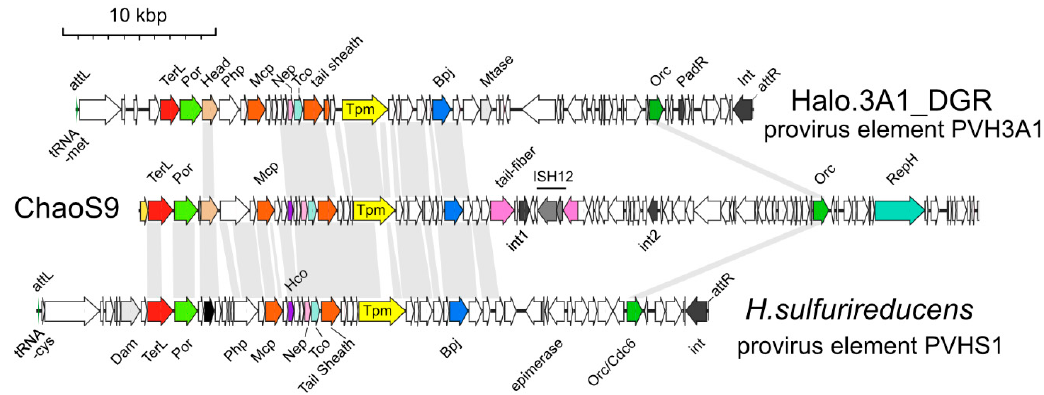
Figure 6. Provirus elements PVH3A1 and PVHS1 compared to ChaoS9. PVH3A1 from haloarchaeon strain 3A1_DGR (accession NZ_KK033114; nt 1475908-1520418), and PVHS1 from Haa. sulfurireducens strain M27-SA2 (accession NZ_CP011564; nt 1971038- 1927125), are compared to ChaoS9. Grey bands connecting genome maps represent similarity (tBLASTx, >30% identity) between the inferred proteins of ChaoS9 and each provirus. Positions of several annotated proteins and their genes are indicated by color and name; TerL, large subunit terminase (red); Por, portal protein (light green); Head, SPP1_gp7 family head assembly protein, (light brown); capsid proteins such as Mcp (major capsid protein) and Tail sheath protein (brown); Tpm, tape measure protein (yellow); Dam, adenine methyltransferase (light grey); Bpj, baseplate J family protein (blue); Orc1, replication protein Orc1 (green); RepH, plasmid replication protein (turquoise). Scale bar, in kbp, is shown at top.